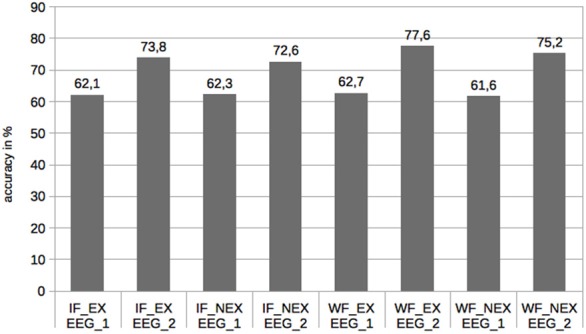
Correctness rates in relation to conditions.